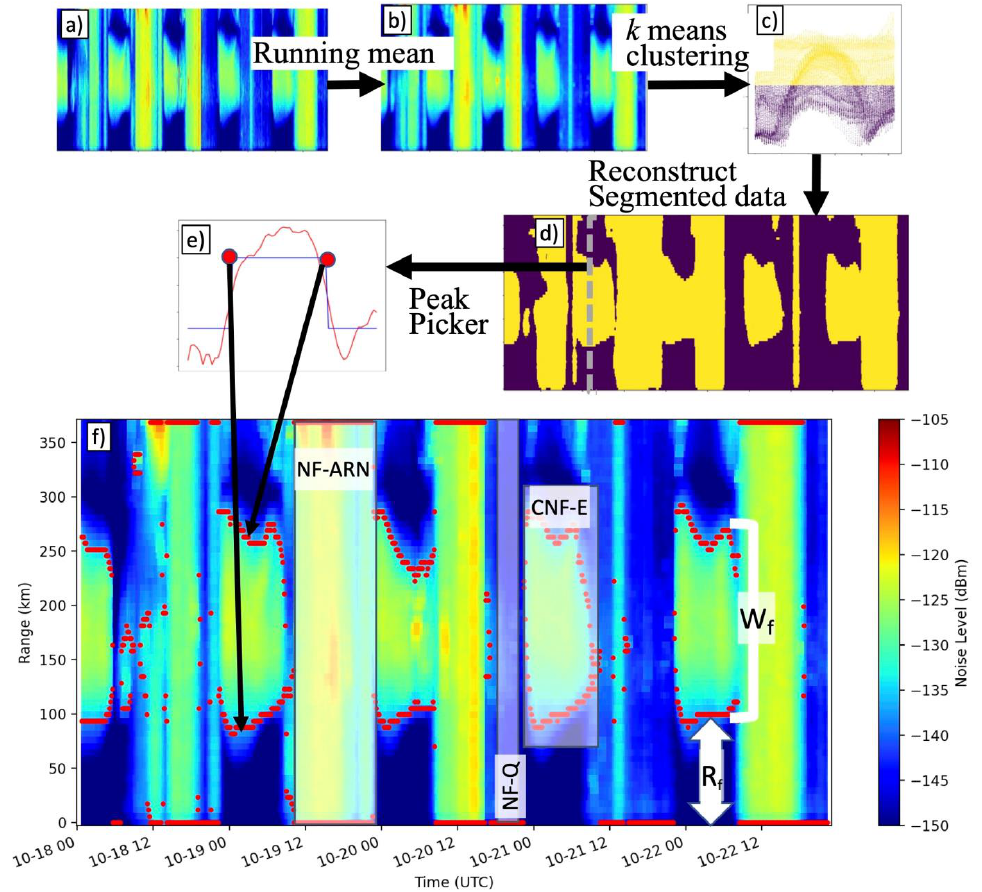
Figure 5. Spectral C+NF timeseries segmentation process. ( a , b ) A running mean is applied to C+NF timeseries, ( c ) k-means clustering is applied with k = 2 to separate high noise features (yellow) from low noise (purple), ( d ) low noise segments are separated from the high C+NF features, ( e ) peak picking routine is used at each timestep to delineate the edges of the high C+NF features, ( f ) C+NF timeseries showing definition of range to feature (R f ), feature width (W f ) and feature types (CNF-E, NF-ARN, and NF-Q). One important consideration to this algorithm is that while the vertical receive an- tenna used in the CODAR SeaSonde is omnidirectional, it is polarized in the horizontal plane which means it is not optimal for measuring signals arriving from directly overhead (elevation angle = 90°). It is not a standard practice to measure the CODAR SeaSonde